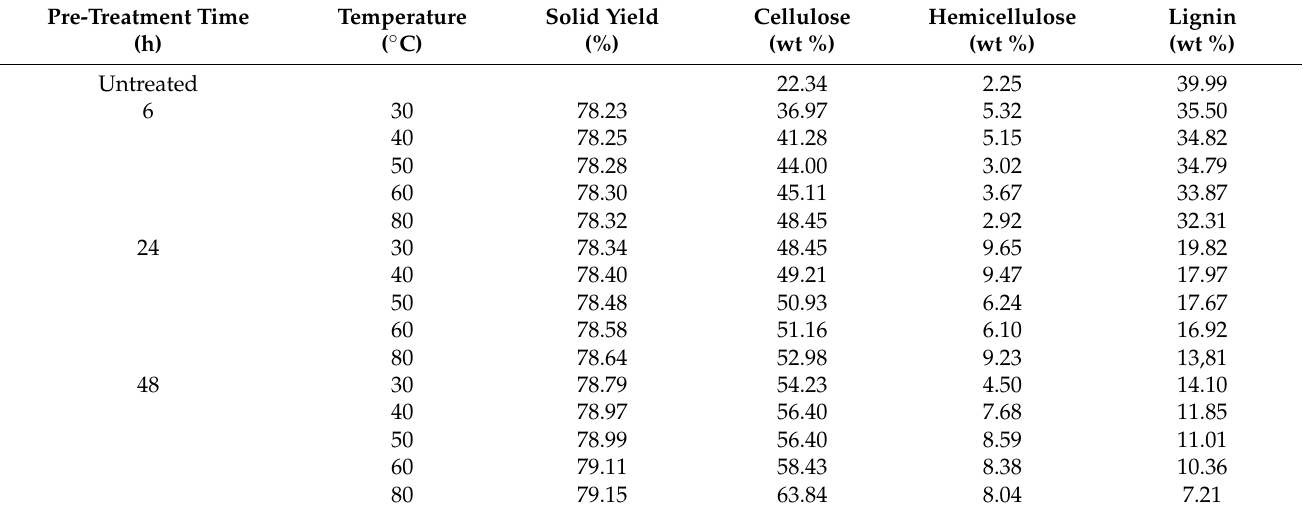
Table 2. Effect of CHPA pretreatment temperature and time on the composition of the rice husk samples. Pre-Treatment